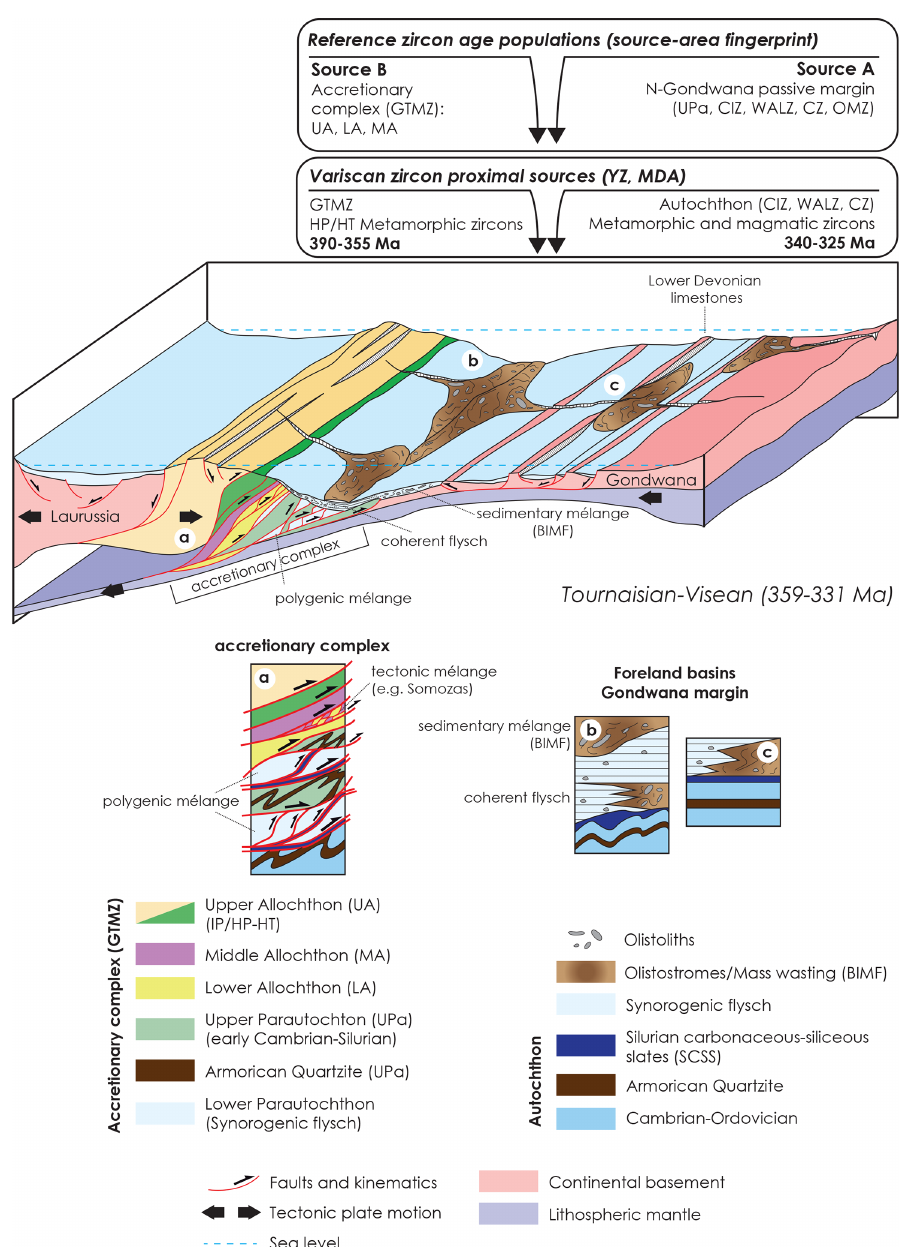
Figure 14. Sketch of the orogenic collision at the Tournaisian–Visean displaying the trench-fill turbidites and the block-in-matrix deposits. The upper part represents the input of the zircon populations from different sources and